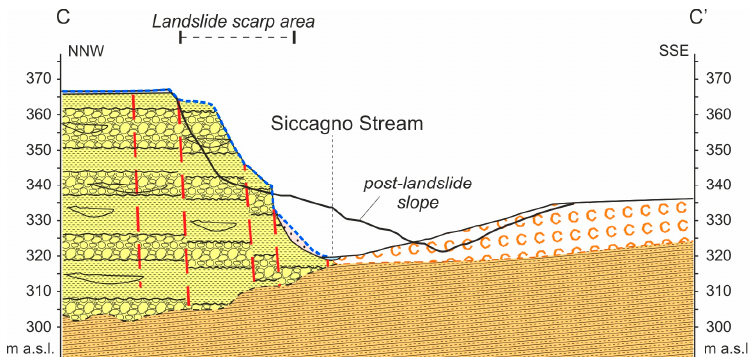
Figure 17. Pre-landslide geological and geomorphological cross-sections of the Castelnuovo landslide area (location in Figure 14); the thick black line is the post landslide topography (cfr. Figure 16).